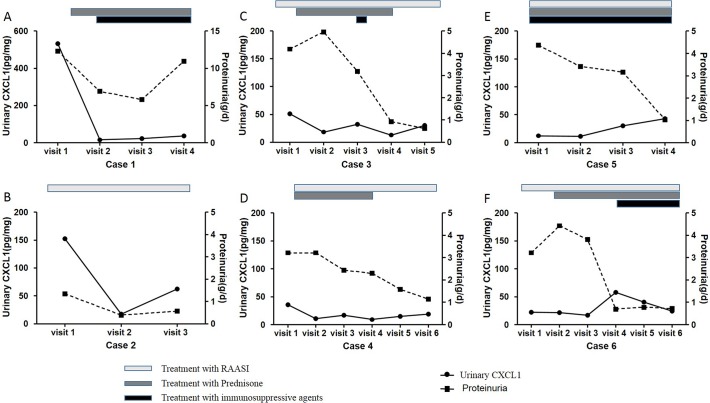
Correlation of urinary CXCL1 level with proteinuria during follow-up period.For patients with high baseline urinary CXCL1 levels (case 1 & case 2), the variation tendencies of urinary CXCL1 and proteinuria were almost the same (A & B). For patients with middle levels of baseline urinary CXCL1 (case 3 & case 4), although proteinuria relieved a lot, urinary CXCL1 levels just decreased a little (C & D). For patients with low levels of baseline urinary CXCL1 (case 5 & case 6), decreased urinary CXCL1 levels were not observed accompanied with proteinuria remission (E & F). Treatments are depicted as grey-level-coded bars, on behalf of the period of using time.